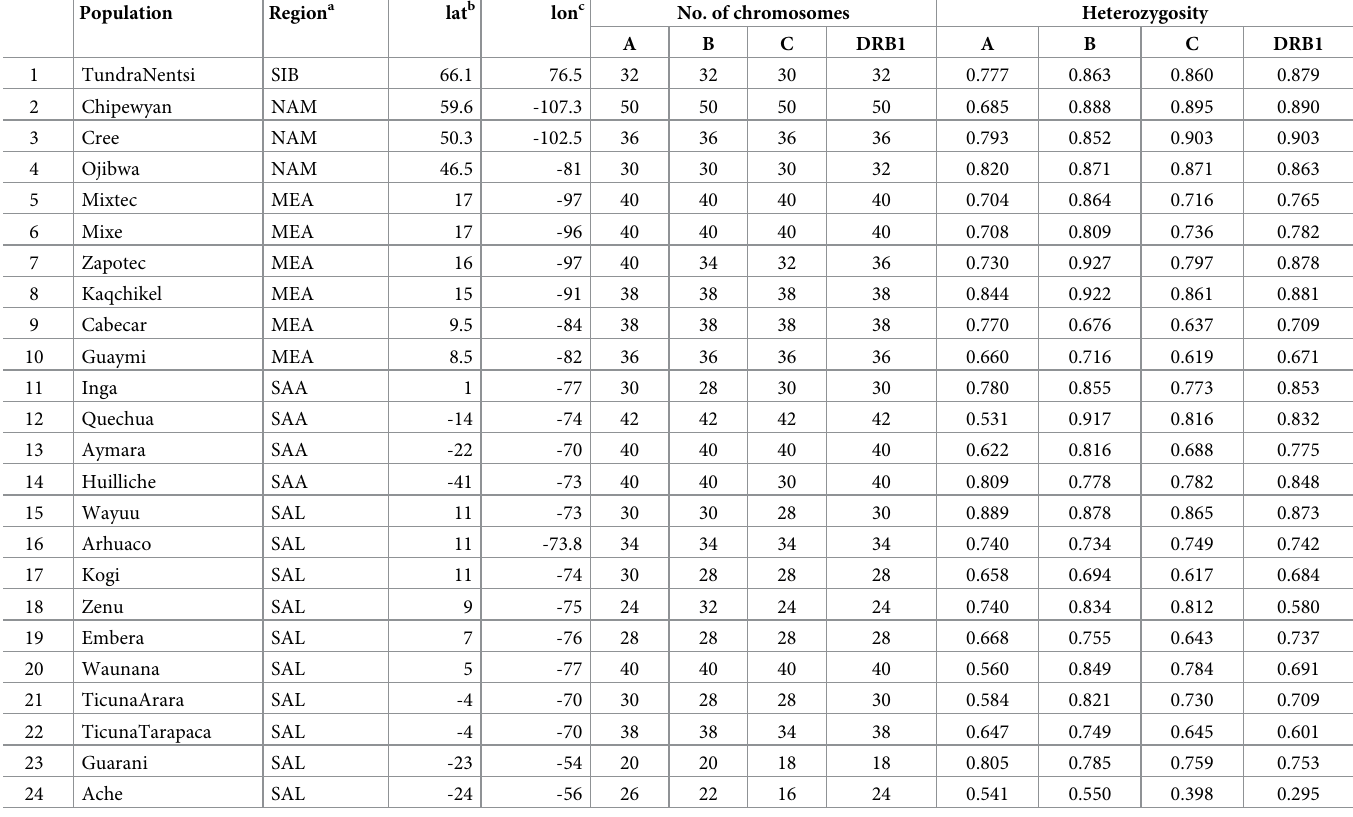
Table 1. Sample sizes and